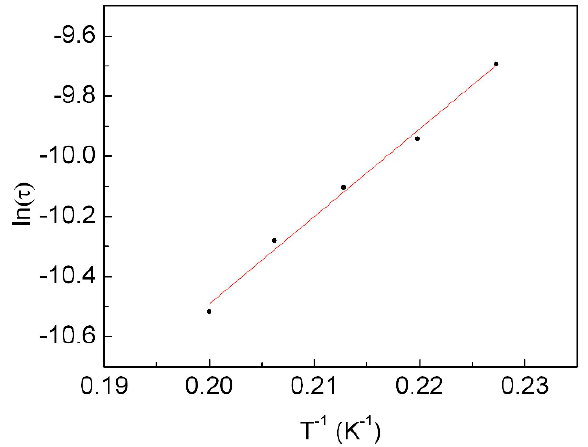
Figure 10. The ln( τ ) vs. T − 1 plot under the optimum dc field of 800 Oe for 1-Dy . The solid is fitting by the Arrhenius law in temperature range of 4.4–5 K with parameters τ 0 = 8.3 × 10 − 8 s, U eff = 29 K.